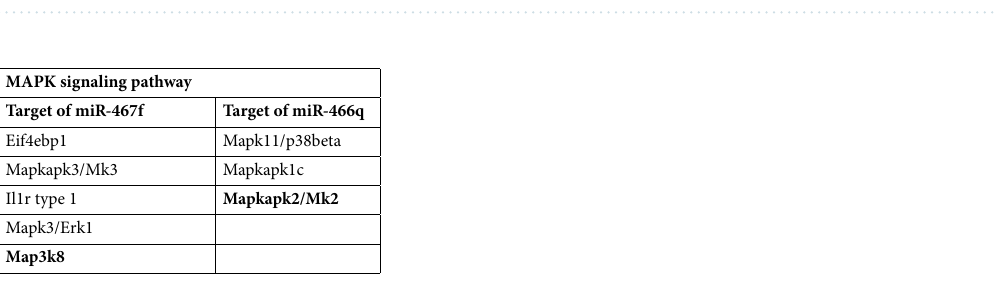
Table 2. Components of the MAPK signaling pathway which are predicted target genes of miR-467f and miR- 466q.